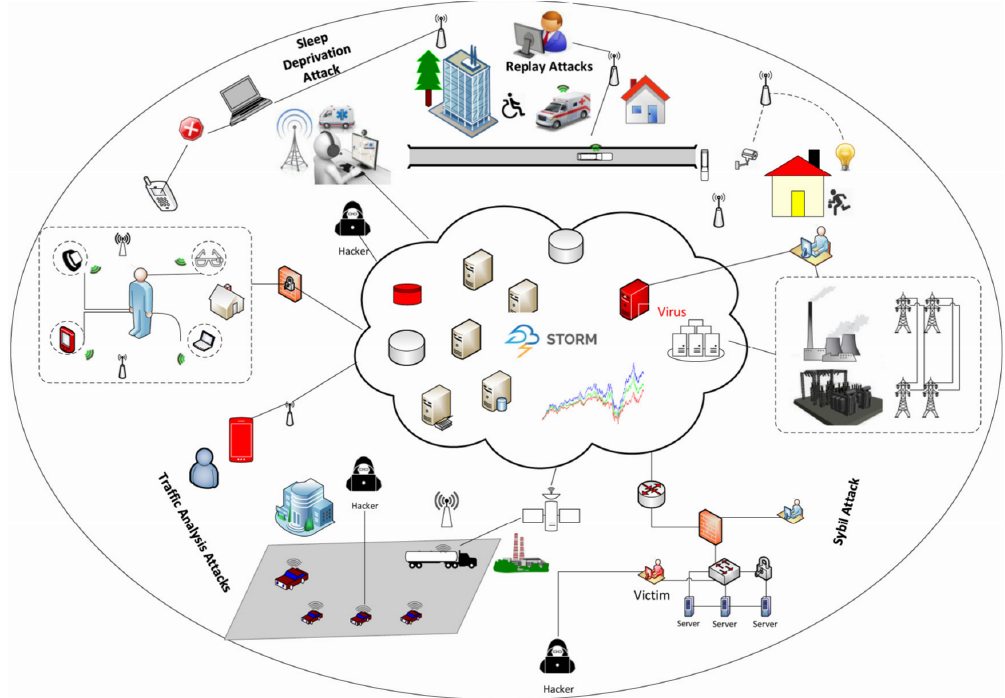
Figure 1. Threats in different IoT